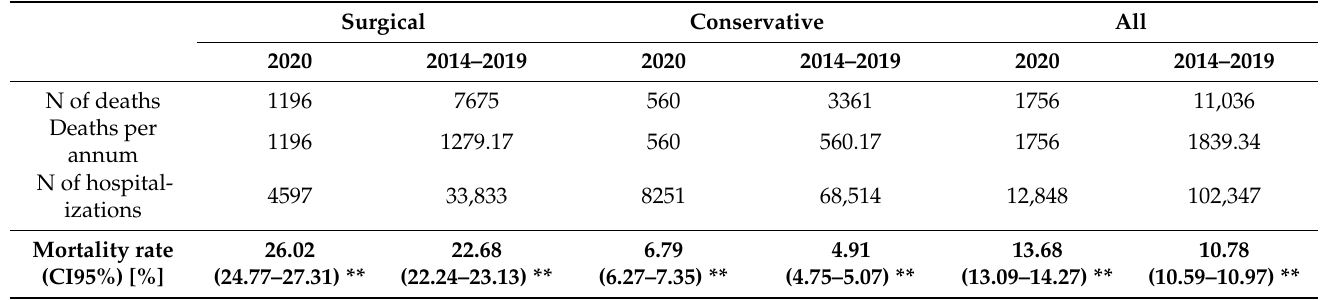
Table 4. Comparison of mortality between the pre-COVID-19 period and 2020. ** p < 0.001. Surgical Conservative